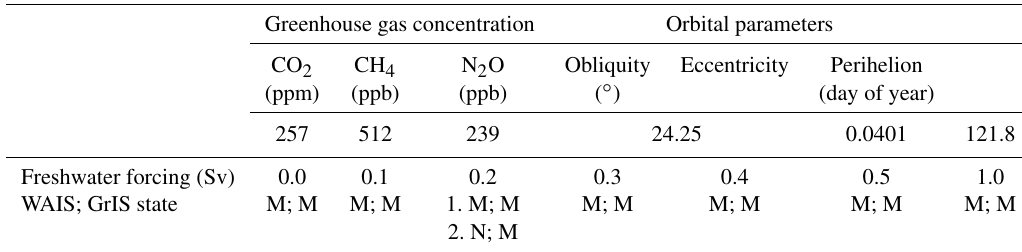
Table 1. Greenhouse gas concentrations, orbital and freshwater forcing, and state of the ice sheets (GrIS: Greenland ice sheet; M: modern-day ice sheet; N: no ice sheet and orography flattened) for the GCM simulations at 130ka.